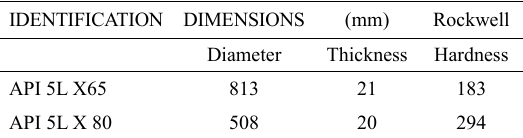
Table 1. Characteristics of the API 5L steel tubes. IDENTIFICATION DIMENSIONS